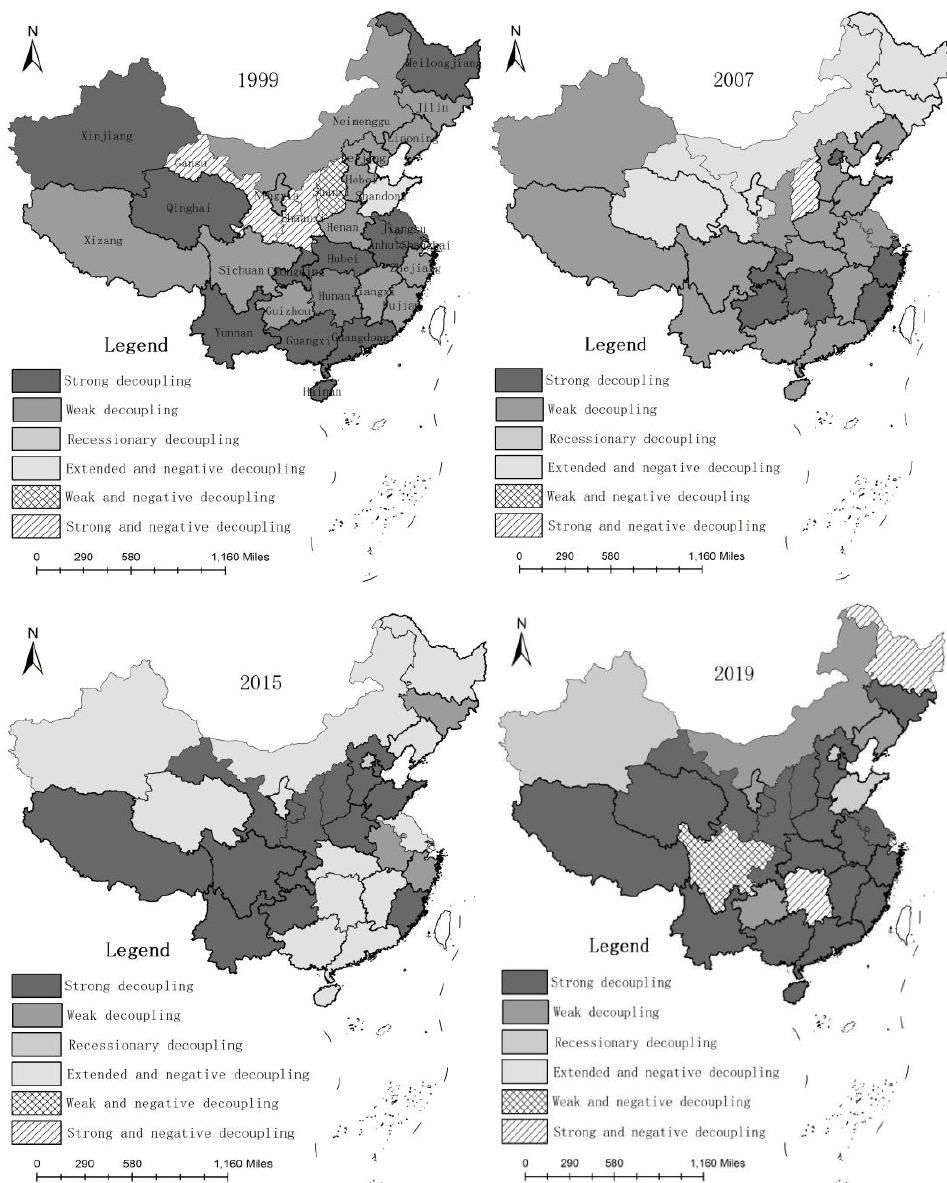
Figure 2. The temporal and spatial difference of decoupling relationship.